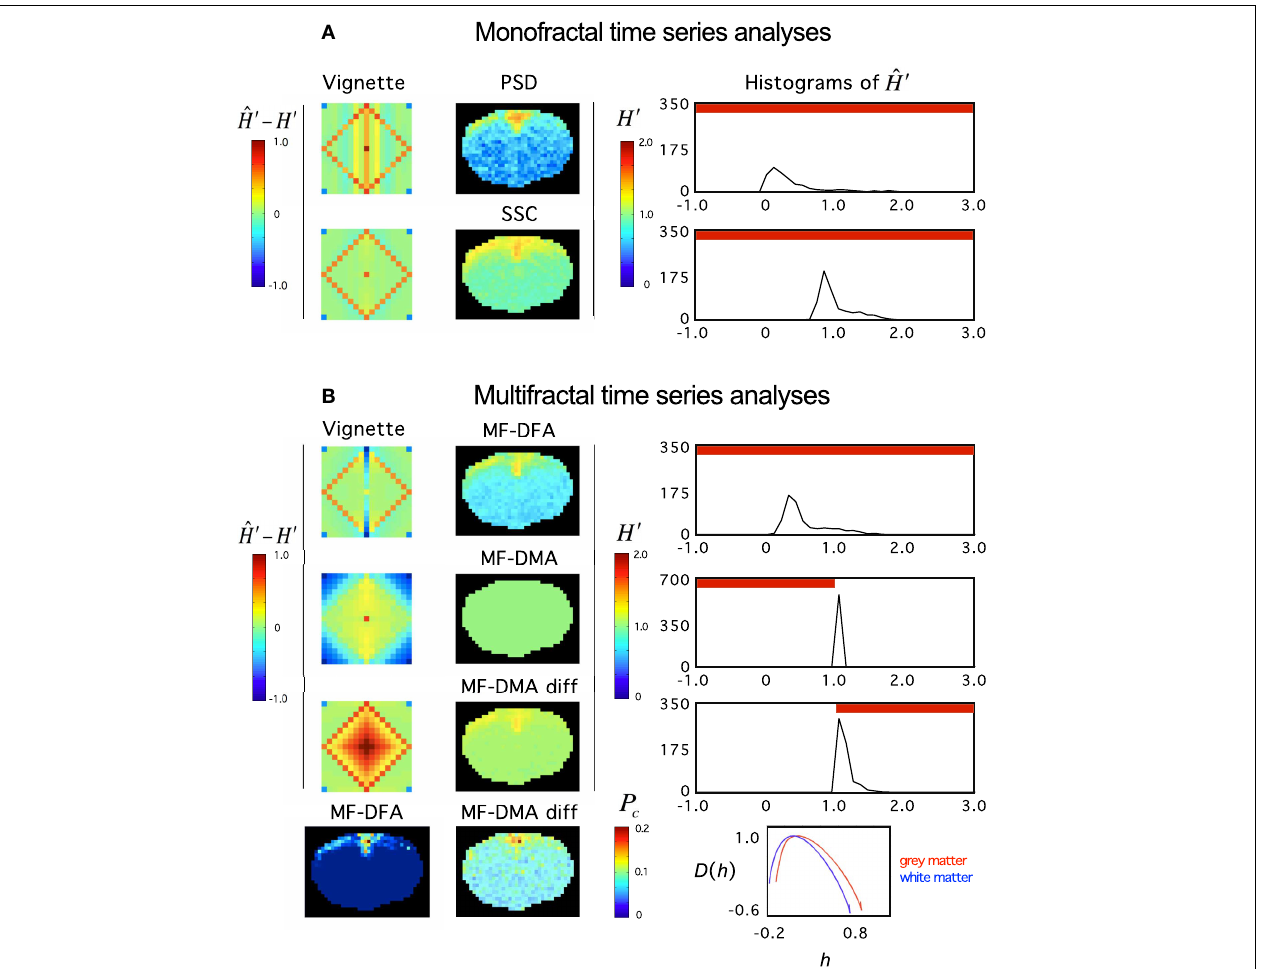
should be taken as precise. Given that most values in the fGn range fall into the range of complete uncertainty of the MF-DMA (See Figure 6 at q = 2) and that MF-DMA cannot handle fBm signals, all estimates ends up being 1.0. Differencing the signals (including those of the vignette) changed the situation dramatically. As seen on the vignette, the originally fBm signals would be mapped into the fGn range that can be handled by MF-DMA very well. Actually better than the original fGn signals where slight overestimation is seen.This kind of behavior of MF-DMA may have inference with the findings of Gao et al. (2006). Also note, that the double differenced fGn signals end up being overestimated.These effects are worth to investigate in order to characterize the impact of the fGn/fBm dichotomy on the performance of these time domain multifractal tools when signals are being converted between the two classes. P c – as a global multifractal measure – captures a topology similarly to the monofractal estimates.The corresponding singularity spectra do separate with the likelihood that the underlying multifractalities indeed